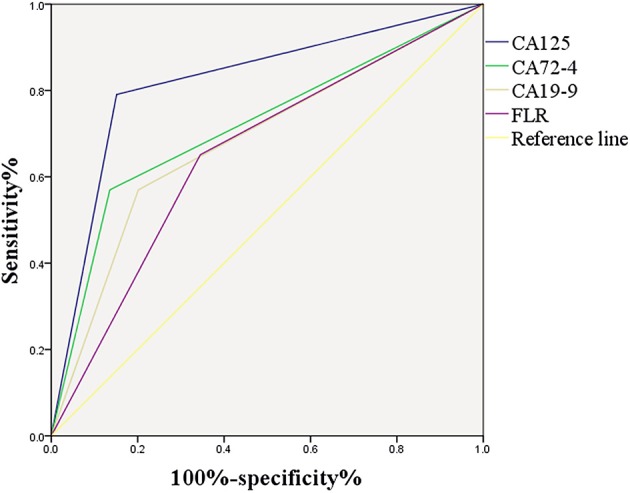
ROC curve of the important risk factors.